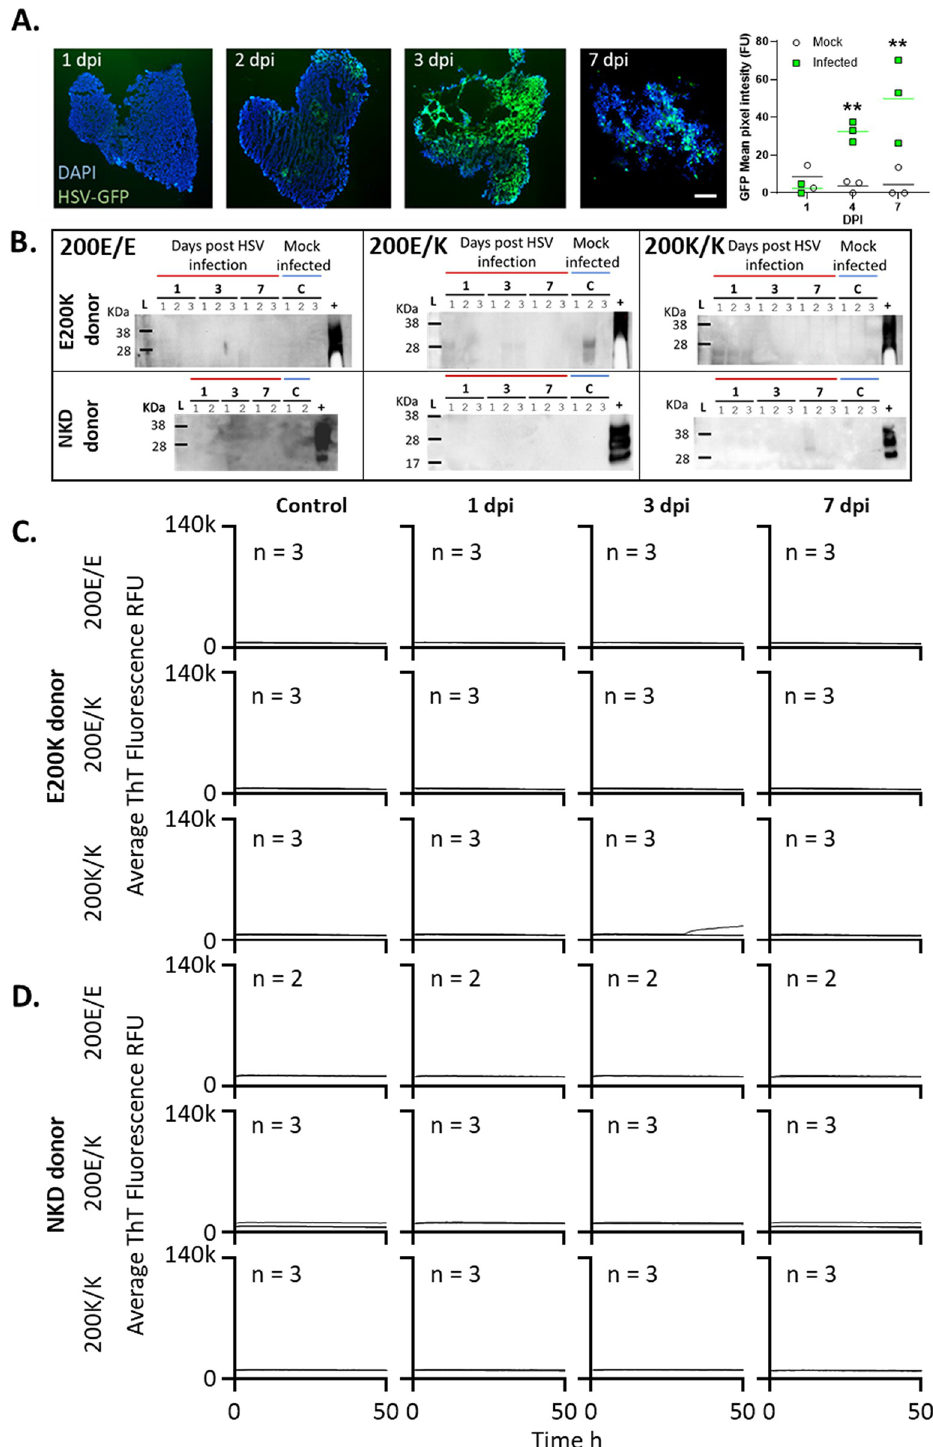
Fig 3. Acute HSV1 infection does not cause production of misfolded PrP or prion seeding activity accumulation. Organoids were infected with a 0.00001 MOI of McKrae HSV1. A. Emergence of HSV1-GFP over 1–7 dpi demonstrating active viral replication and changing organoid morphology by 7 dpi. Scale bar = 500 μ m. Quantification of GFP fluorescence in organoids over time indicating production of virus is shown right. Individual points show single organoids (n = 3) and horizontal lines show the average intensity. �� p < 0.01 from the background